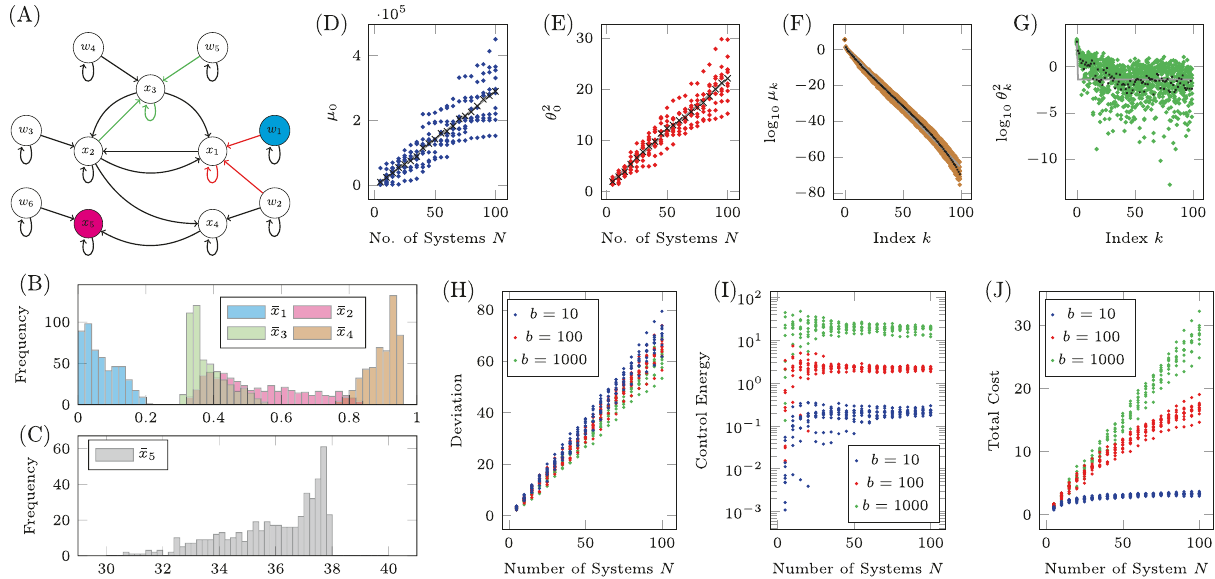
Fig. 5 The Jacobian of a system with uncertain parameters. A The Jacobian of the simpli fi ed model of autophagy represented as a network. Red edges have weights in which C NU appears explicitly and green edges have weights in which C EN appears explicitly, while black edges have weights that may or may not implicitly depend on C EN and C NU . For 500 choices of C NU and C EN , the stable fi xed point is computed and collected in the bar plots in B (for (cid:2) x k , k = 1, 2, 3, 4) and C (for (cid:2) x ). Note that even though C NU and C EN are drawn from uniform distributions, the values of the fi xed point are not un fi formly 5 distributed. The largest eigenvalue μ 0 and associated value θ 2 are shown in D and E for 10 realizations of N random choices of C NU and C EN . For 10 0 realizations of N = 100, the complete eigendecomposition, μ k and θ 2 k , are shown in F and G where Assumptions 1 and 2 are seen to hold. The resulting deviation, control energy, and total cost are shown in H – J ,